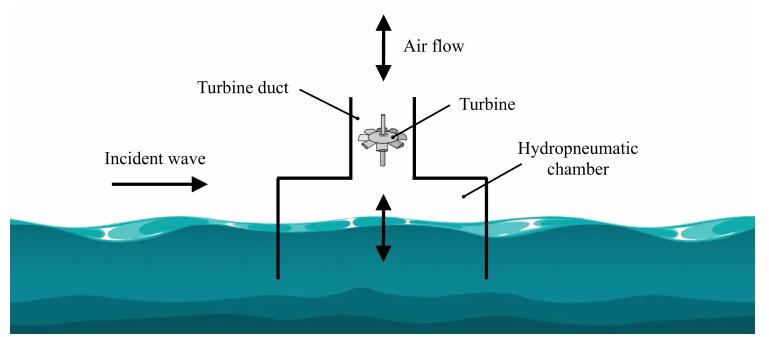
Figure 1. Schematic representation of the operating principle of an OWC